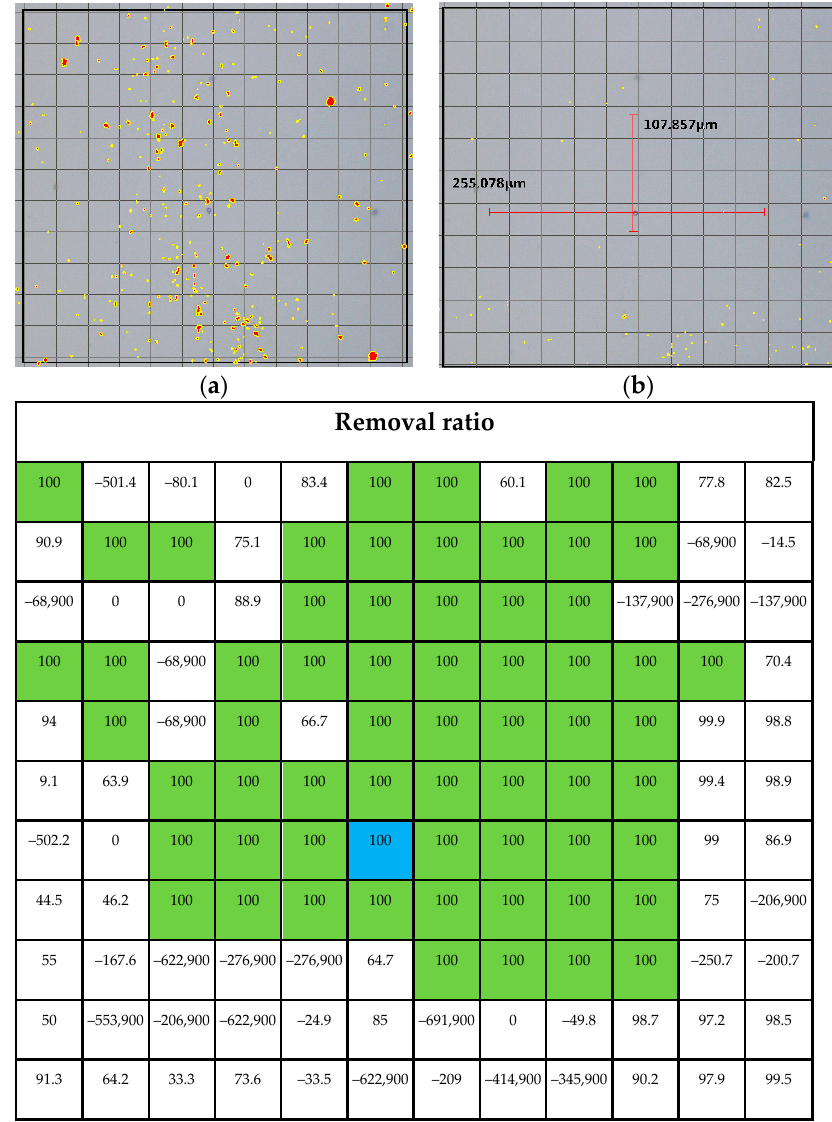
Figure 13. ( a ) Photo of before cleaning when pulse number is 110 number and gap distance is 20 µ m, ( b ) photo after cleaning of ( a ), and ( c ) particle removal ratio map.